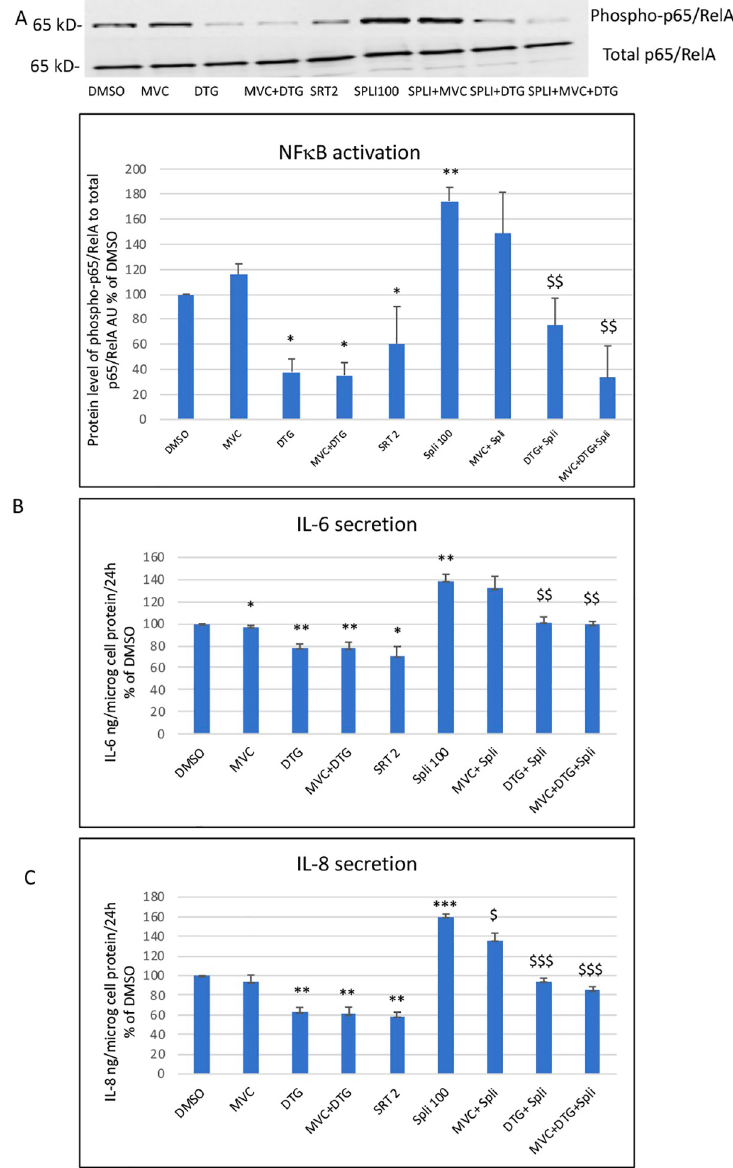
Fig 2. Effect of the antiretrovirals and of the SIRT-1 activator (SRT1720) and inhibitor (splitomycin) on NF κ B activation (A) and secretion of IL-6 (B) and IL-8 (C). A representative blot of phospho-p65/RelA and total p65/RelA is shown. The level of NF κ B activation was evaluated by the ratio of phospho-p65/RelA to total p65/RelA. IL-6 and IL- 8 secretion was evaluated as the level of IL-6 or IL-8 produced in 24 h in the culture medium and related to the total cellular protein content. The histograms represent the mean+/-SEM value as compared to the DMSO control set at 100% of 4 independent experiments. SRT2: SRT1720 2 μ M, Spli100: splitomicin 100 μ M The comparisons used Welch’s correction of Student T-test. � p < 0.05, �� p < 0.01 versus control (DMSO) $ $ p < 0.01, $ $ $ p < 0.001 versus spli100.